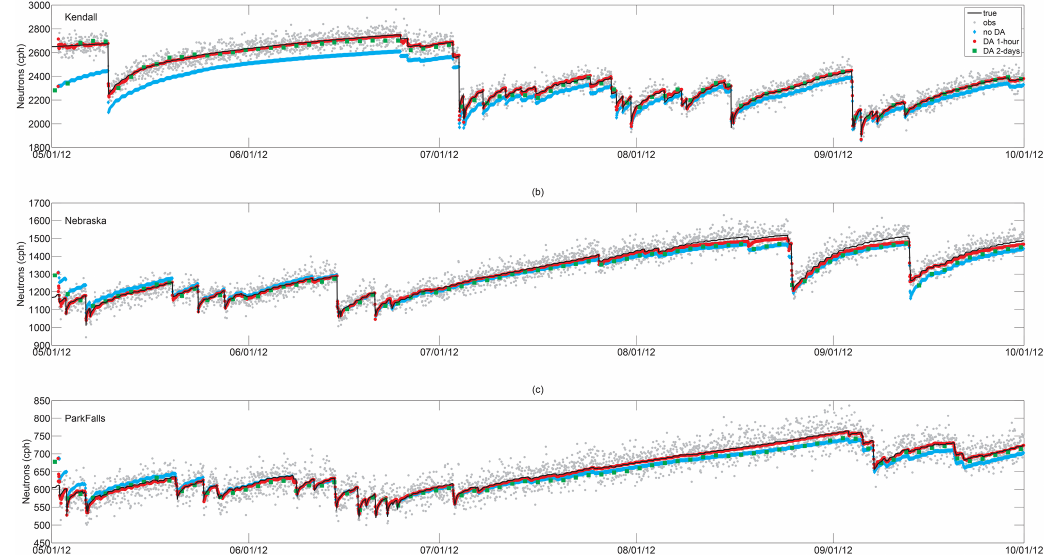
Figure 4. Equivalent neutron intensity (counts per hour – cph) simulated by Noah coupled to COSMIC without (no DA) and with data assimilation characterized by low- and high-frequency retrievals (respectively, DA 2-day and DA 1-hour) compared to synthetic observations (obs) and true intensities. The ensemble mean of the prior distribution is shown for all ensemble simulations. Table 3. Summary of statistics computed for Noah for assimilation of synthetic neutron intensity measurements in counts per hour (cph). Metrics are computed with respect to both true counts and synthetic observations, respectively “w.r.t. True” and “w.r.t. Obs”. The ensemble mean of the prior distribution is used for all ensemble